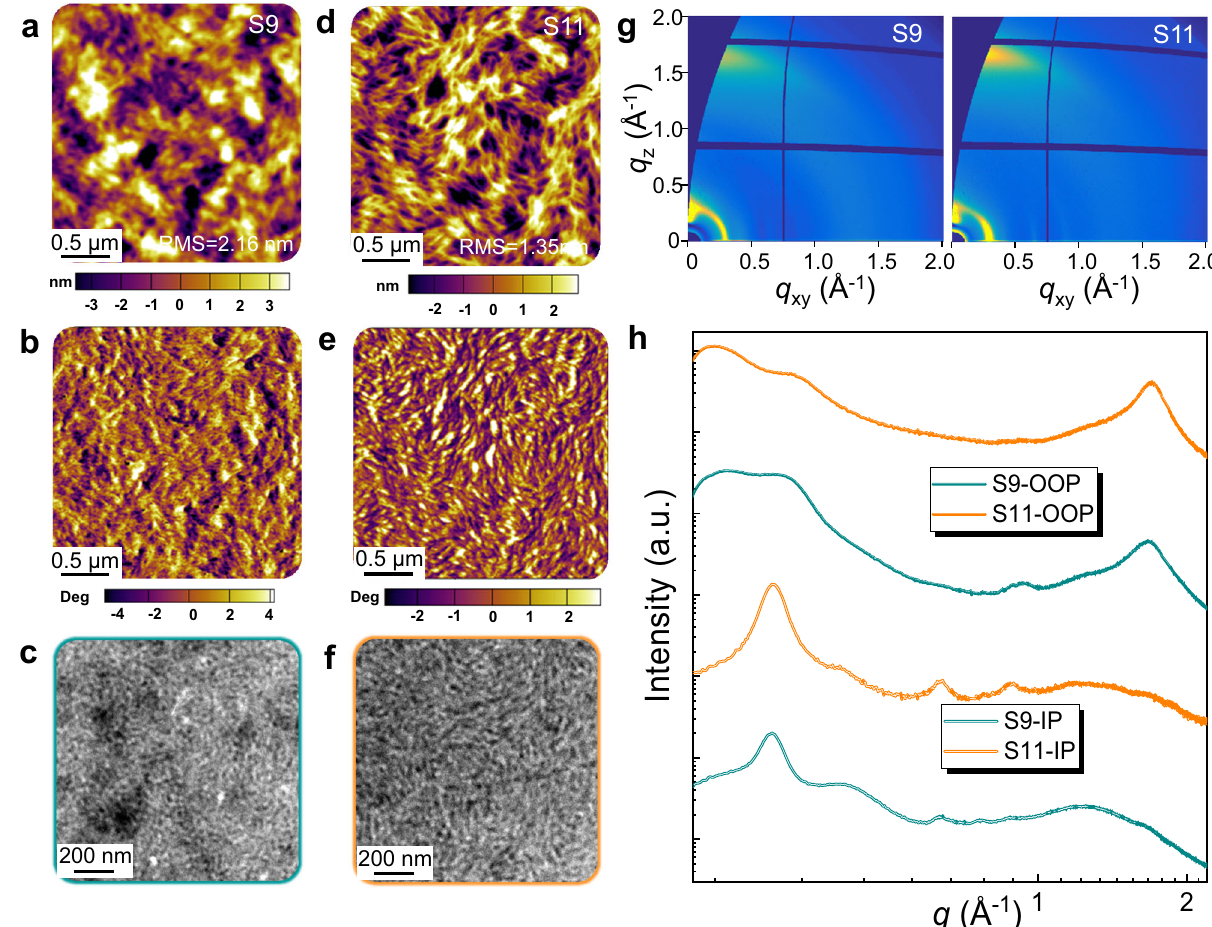
Fig.3|Morphologicalcharacteristicsofthe fi lms.a , b AFMheight, c , d phaseand e , f TEMimagesofS9andS11 fi lms. g 2DGIWAXSpatternsand h scatteringpro fi lesof out-of-plane and in-plane for their corresponding fi